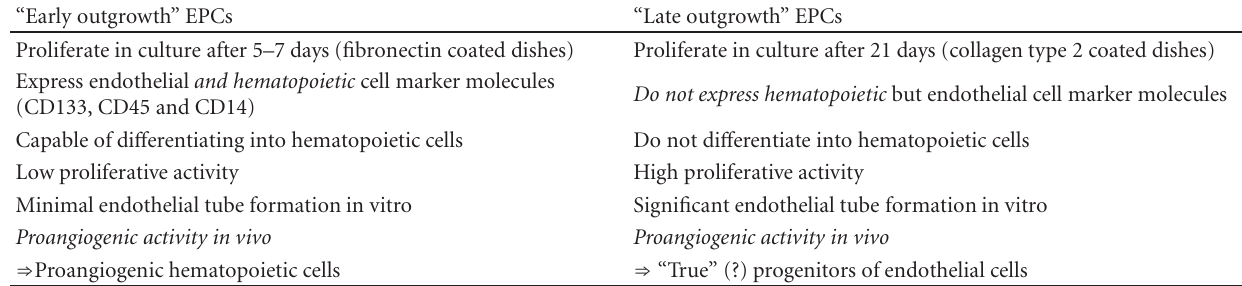
Table 1: Biological properties of “early outgrowth” as opposed to “late outgrowth” EPCs (see text). “Early outgrowth”